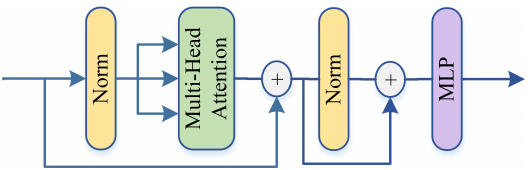
Figure 5. The Transformer